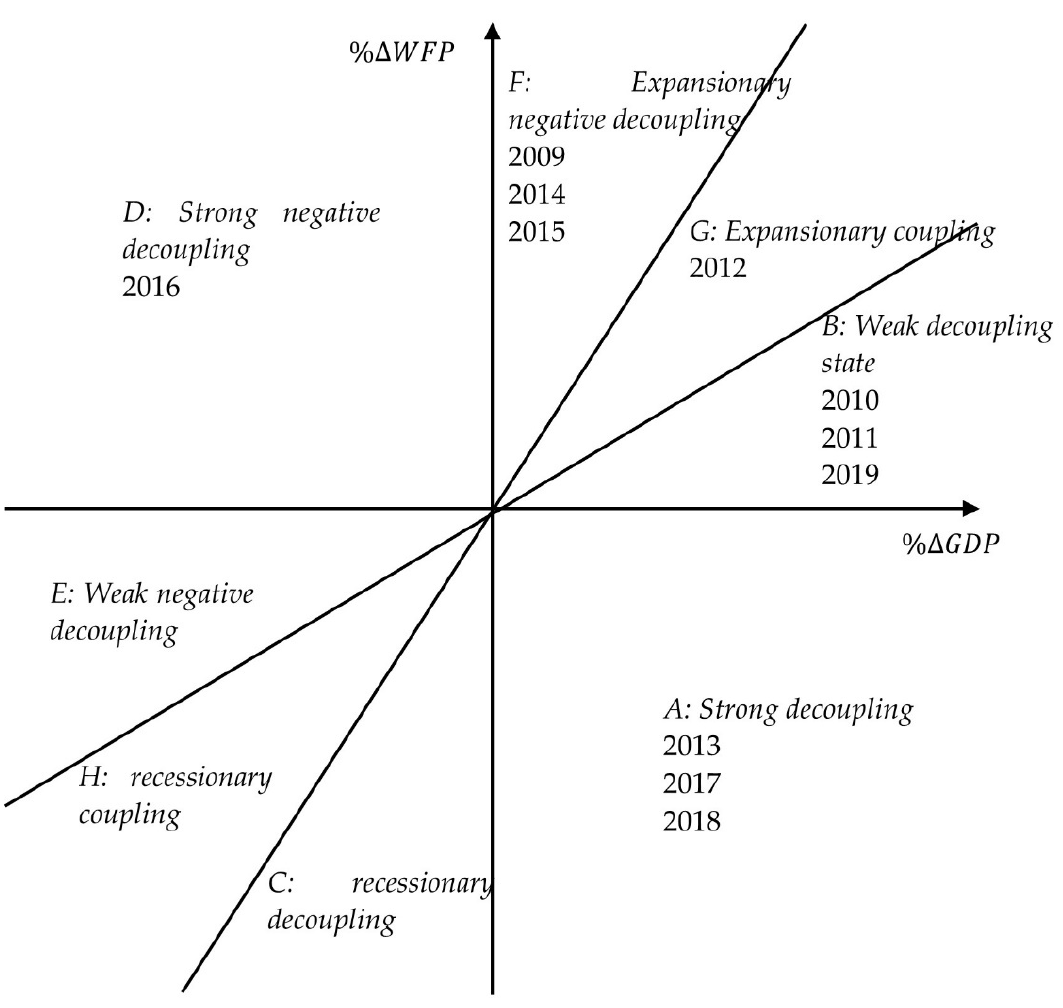
Figure 7. 2008-2019 Pattern of economic growth and water resources utilization decoupling in Tarim River basin. Data source: According to the statistical yearbook of Xinjiang. Table 7. Coordination relationship between economic growth and water resource utilization in Tarim River